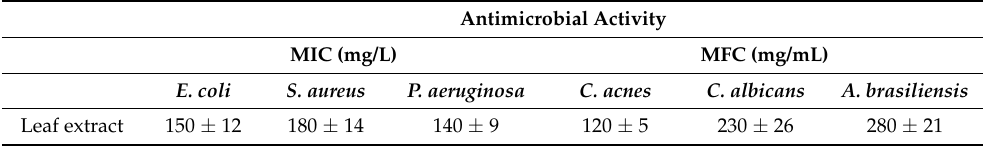
Table 2. Antimicrobial activity of the methanolic extract of C. formosanum leaves fermented by A. oryzae